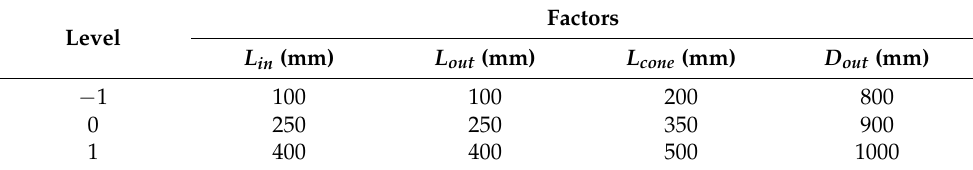
Table 2. Factor level